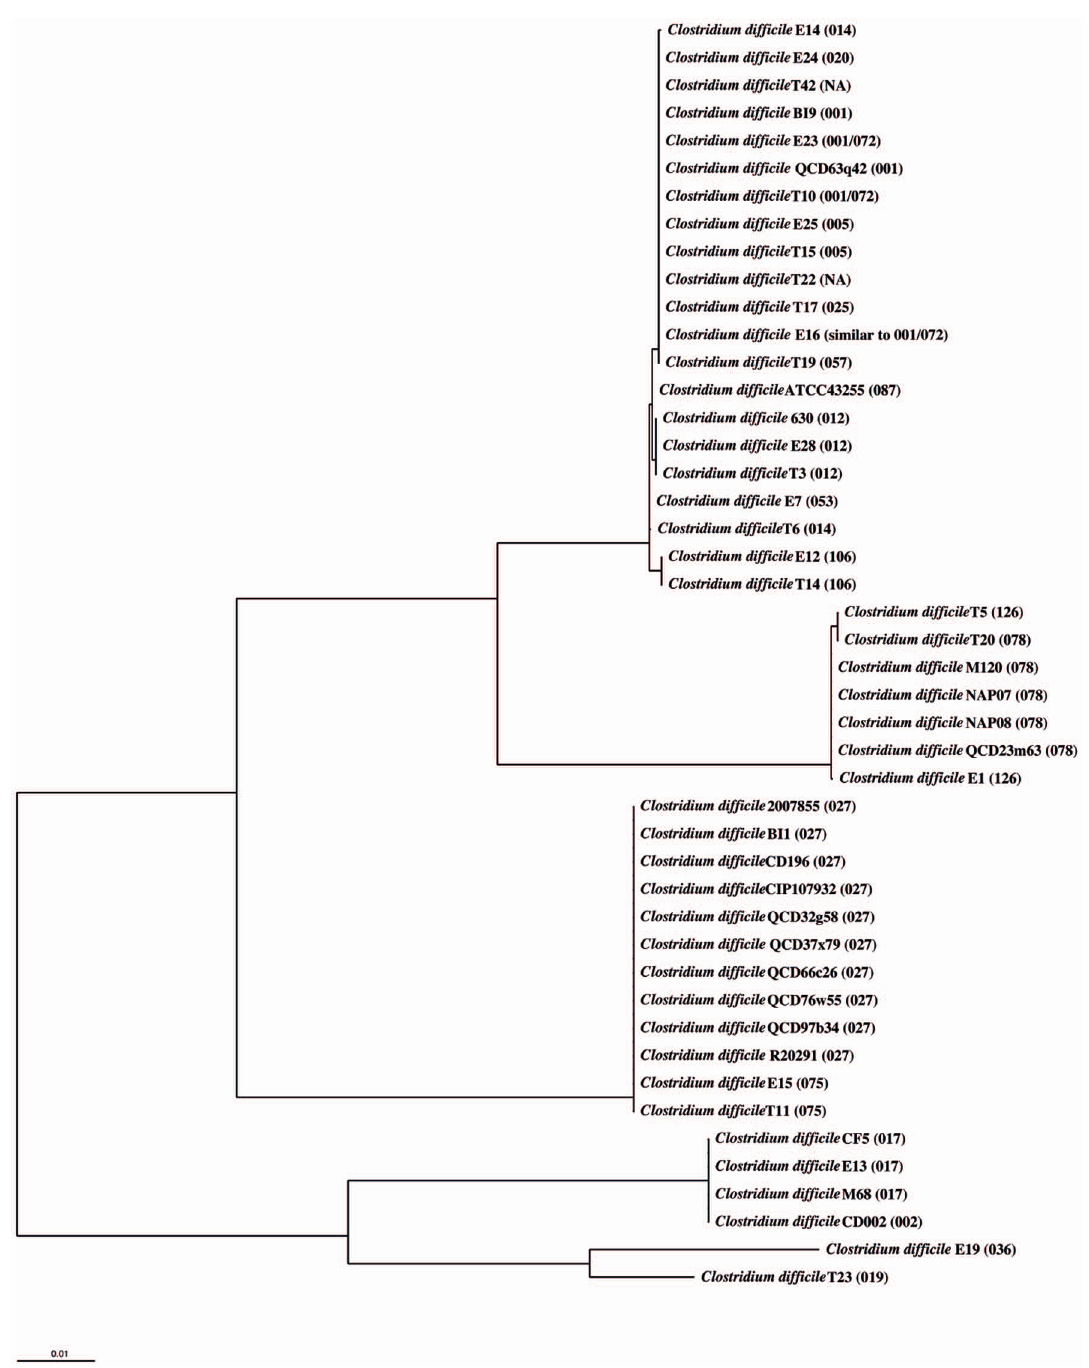
Figure 2. Toxin B gene-based dendrogram. Neighbor joining dendrogram reflecting the similarity for 46 C. difficile strains based on the gene for Toxin B. The distance matrix was computed using the Hamming distance with the Toxin B genes from the 46 C. difficile isolates containing this gene. The strains always cluster together according to their PCR-ribotype. The PCR-ribotype is indicated in brackets.